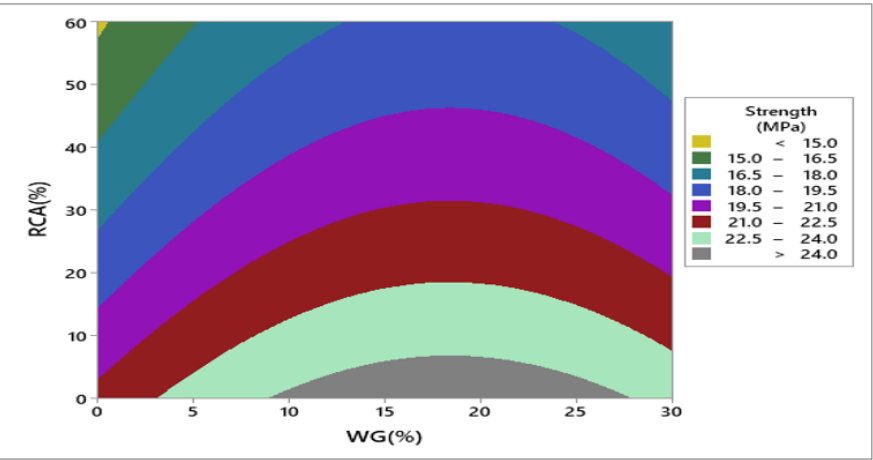
Figure 8. Contour plot of compressive strength.